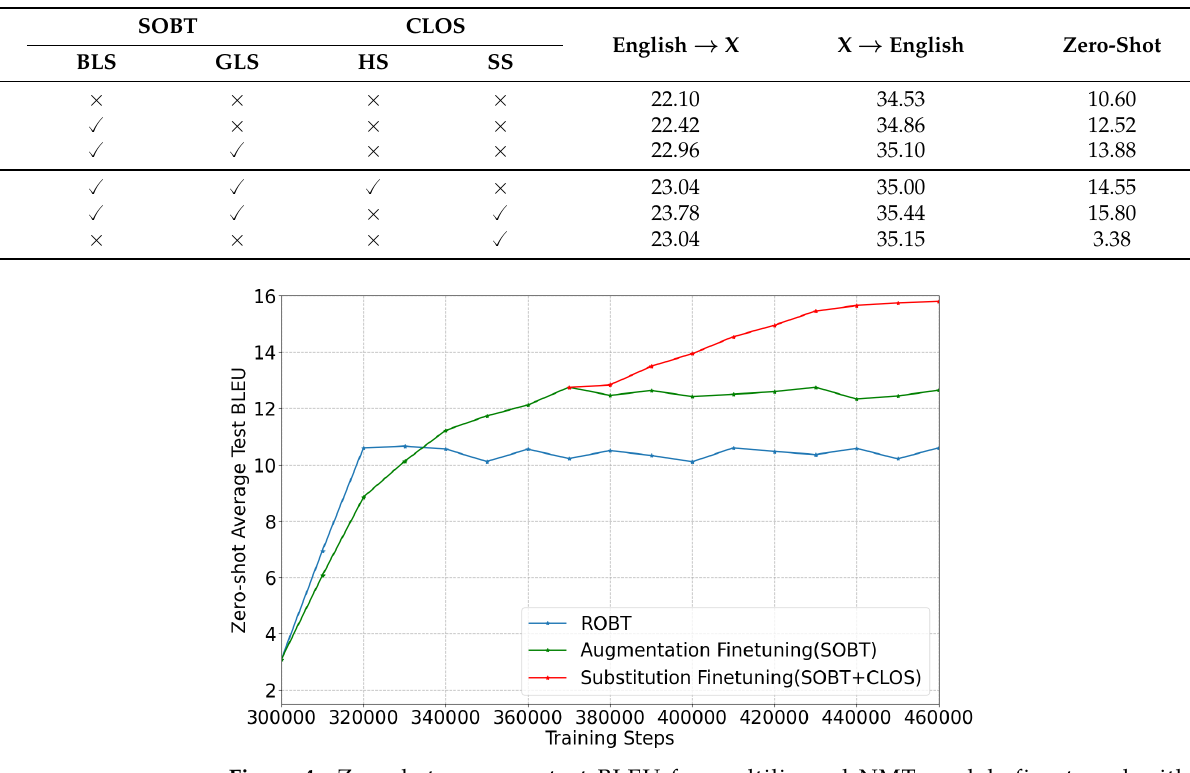
Figure 4. Zero-shot average test BLEU for multilingual NMT models fine-tuned within different methods.